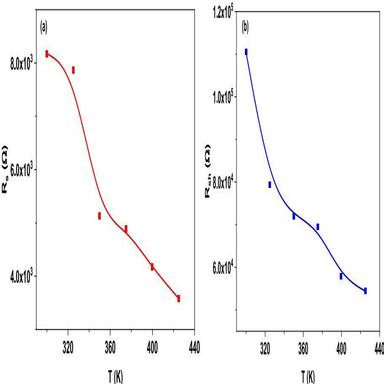
(a) Plot of Rs vs. T, and (b) Plot of Rh vs. T at different temperatures of PVA/p-Si heterojunction.